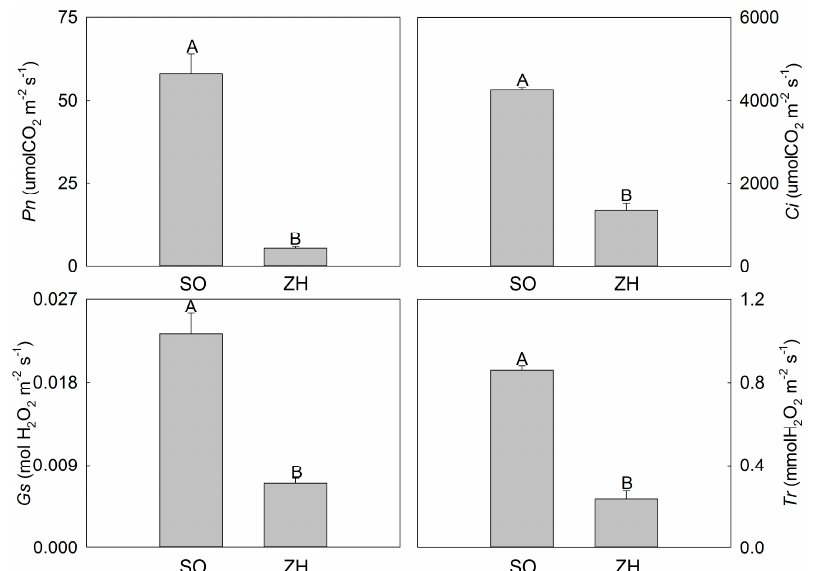
Figure 3. Photosynthetic characteristics of ‘SO’ and ‘ZH’. The values represented the mean ± SD, and different letters indicate very significant differences according to Duncan’s multiple range test ( p < 0.01).